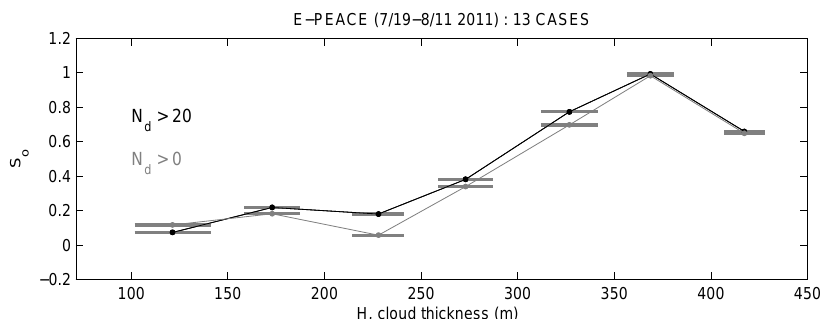
Figure B1. The sensitivity of S o to N d threshold values. One standard deviation of mean thickness for given H intervals is shown as horizontal bars. Dates are indicated in mm/dd format.